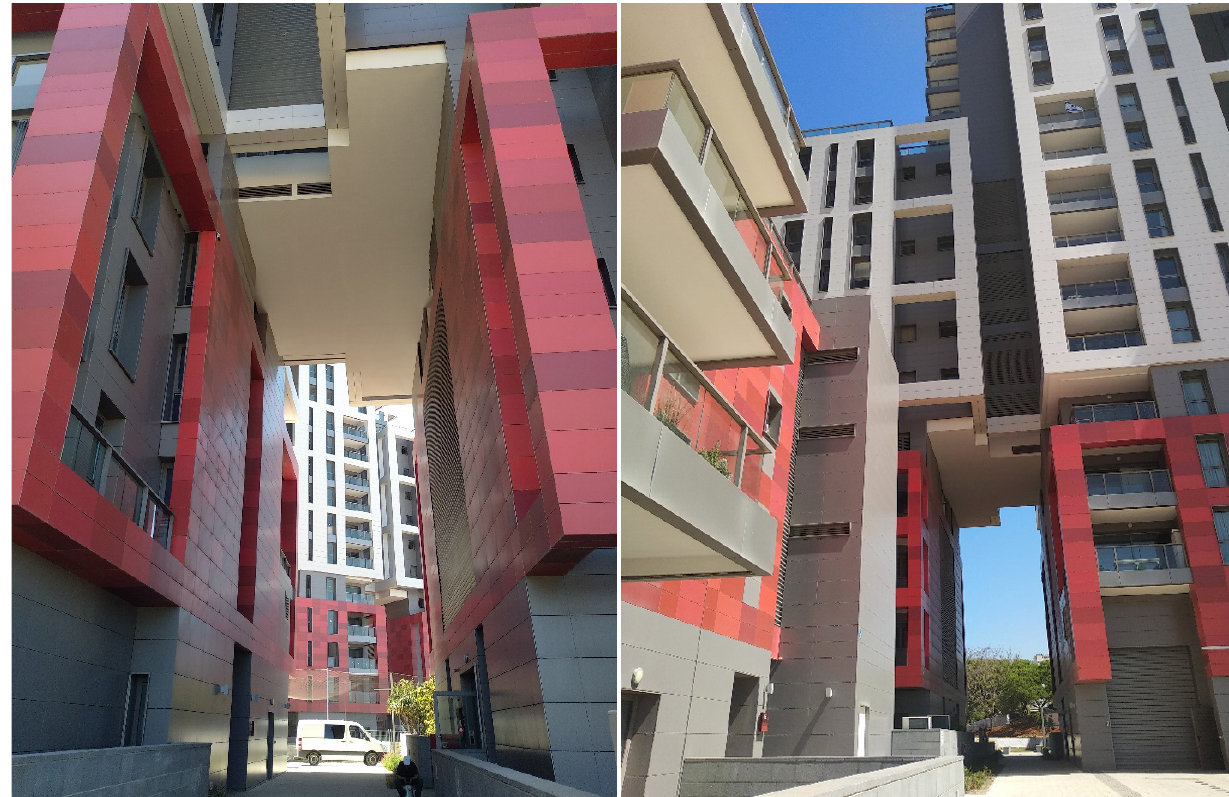
Figure 14. The alleys: crossing the HH’s main axes. Source: Authors